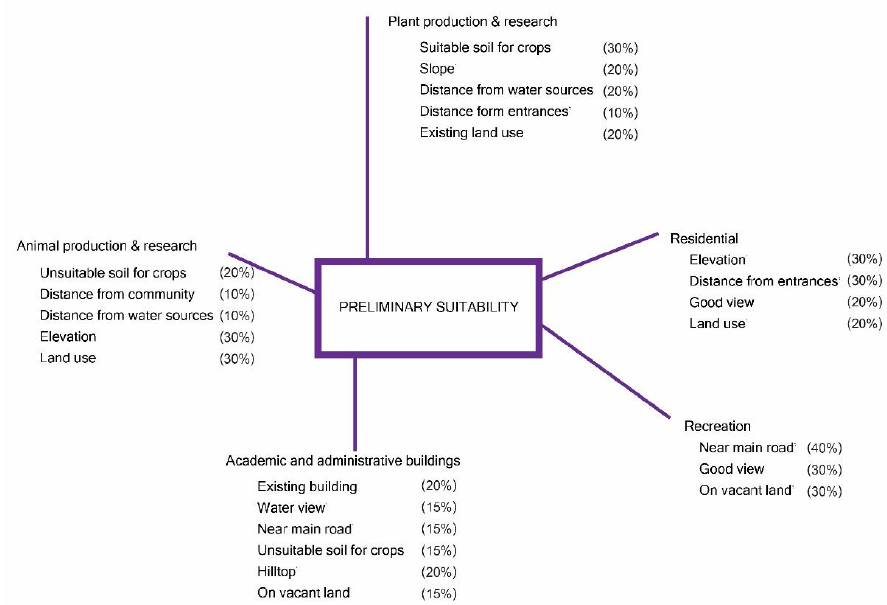
Figure 6. The suitability analysis criteria. Land 2020 , 9 , x FOR PEER REVIEW